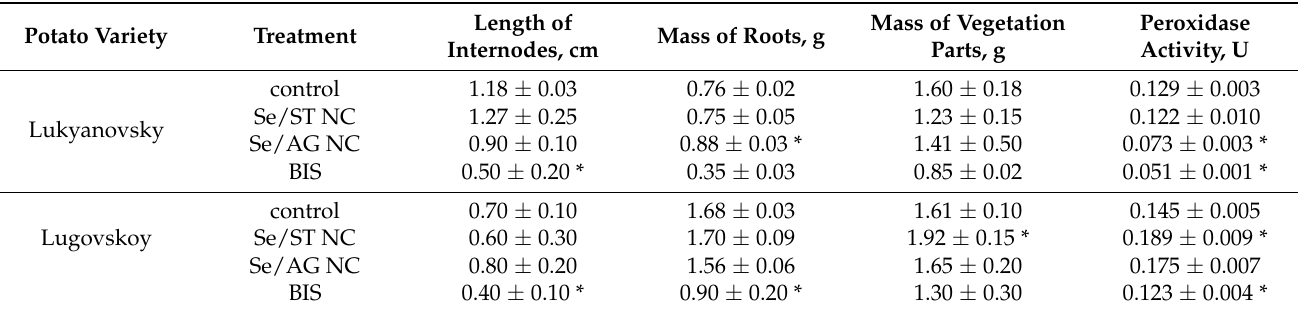
* Statistically different from control at P < 0.05 based on the Mann–Whitney nonparametric test. In each treatment, 25 samples were measured, except for peroxidase, where only three samples were